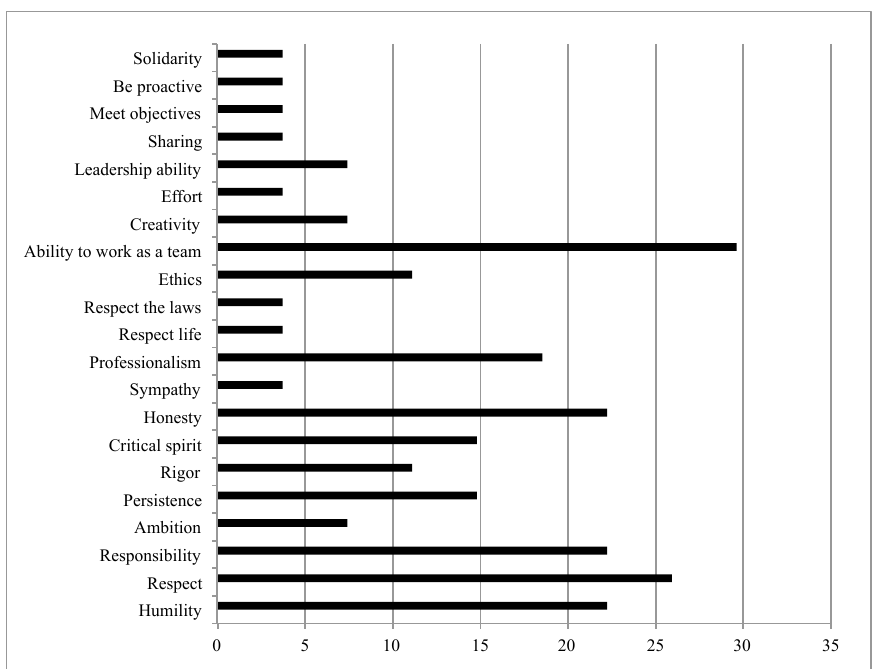
Fig. 1. The most important values in the exercise of the engineering profession as per students' opinions (% of total